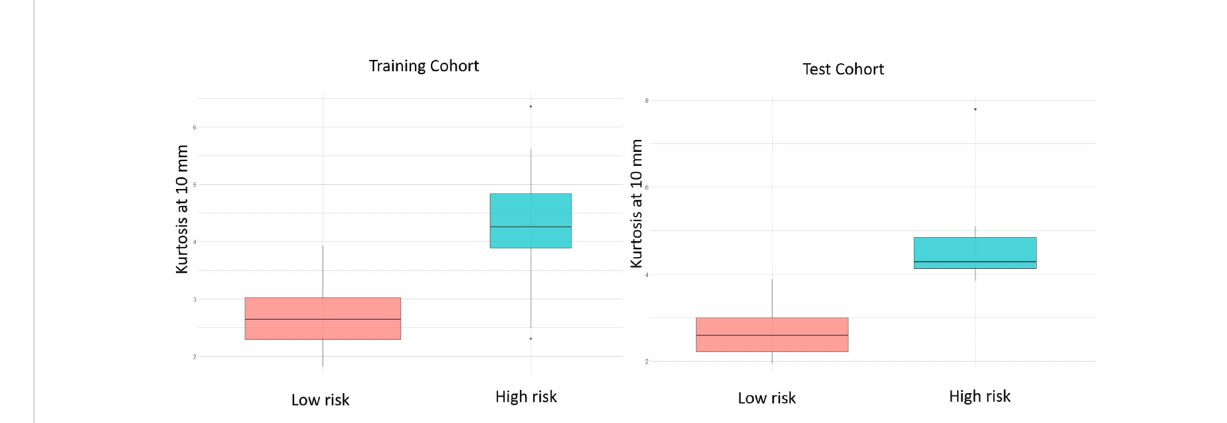
FIGURE 6 Box plots of the most signi fi cantly different deformation feature (kurtosis at 10 mm) between MB patients with poor OS and those with prolonged OS, of the training and test sets respectively, based on the LASSO regression model. p-values for the differences across the 2 risk groups are 0.02 and 0.017 for training and test sets